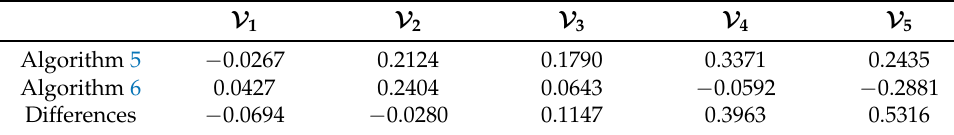
Table 2. Differences in the results obtained by the Algorithm 5 and